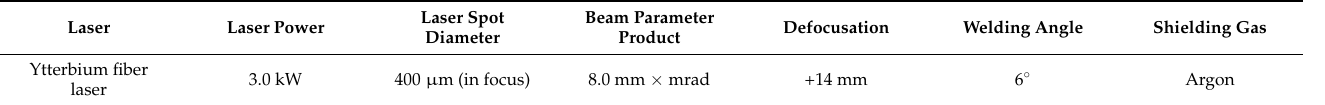
Table 2. Standard welding parameters.